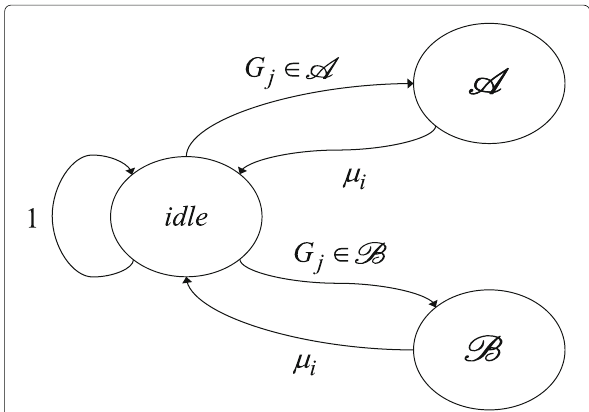
Fig. 3 Markov chain model for the CP. To describe the CSMA period, Markovian model is used to express two sets for the non-collision and collision transmission